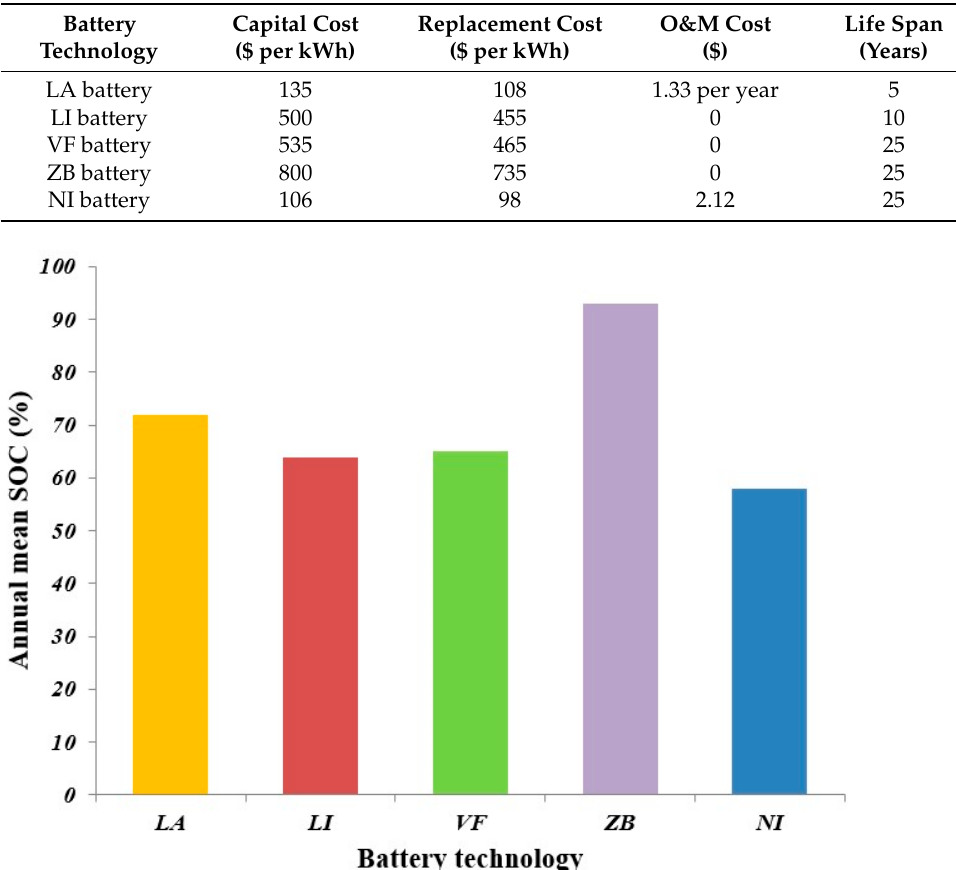
Figure 9. Annual mean SOC of different battery